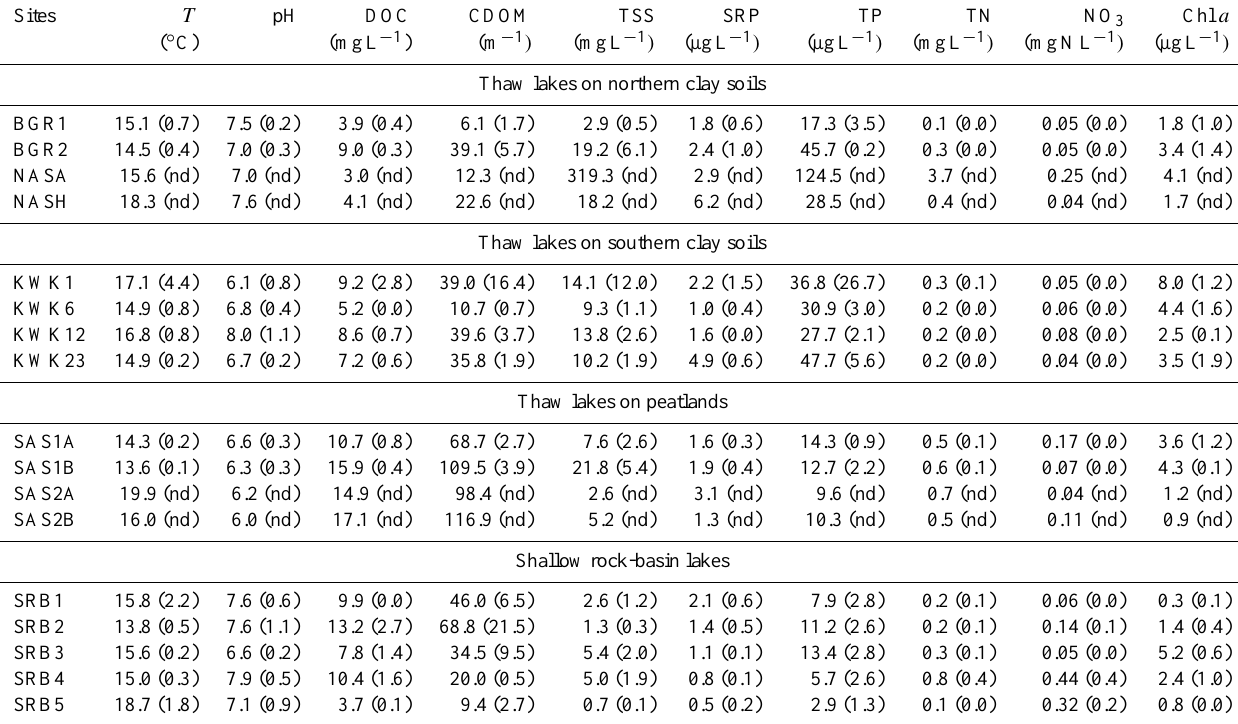
Table 1. Limnological characteristics of the subarctic lakes. Surface values for temperature ( T ), pH, dissolved organic carbon concentration (DOC), colored dissolved organic matter (CDOM), total suspended solids (TSS), soluble reactive phosphorus (SRP), total phosphorus (TP), total nitrogen (TN), nitrate (NO 3 ) and Chlorophyll a (Chl a ). The values are means from 2011 and 2012 ( ± range in brackets; nd denotes no data from